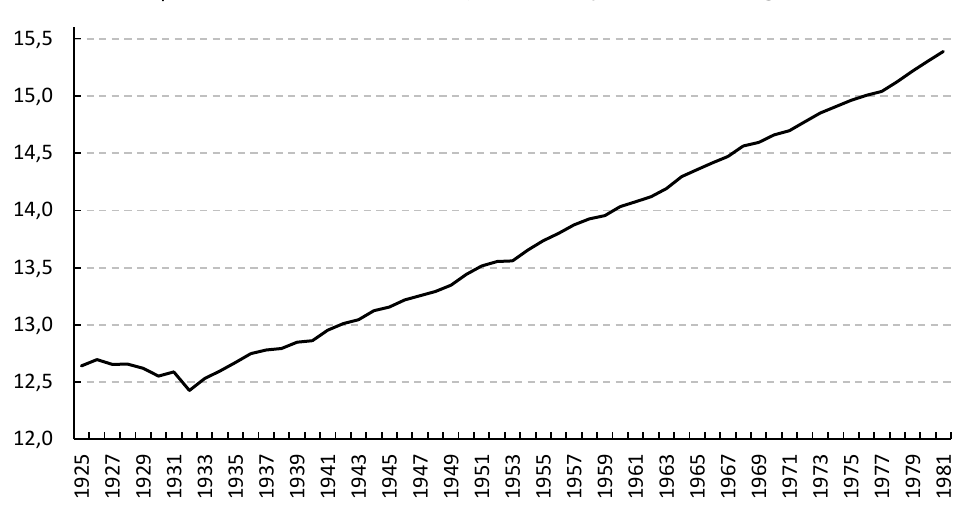
Graph 1 : Gross Domestic Product, millions of pesos 2003 (in logarithms)